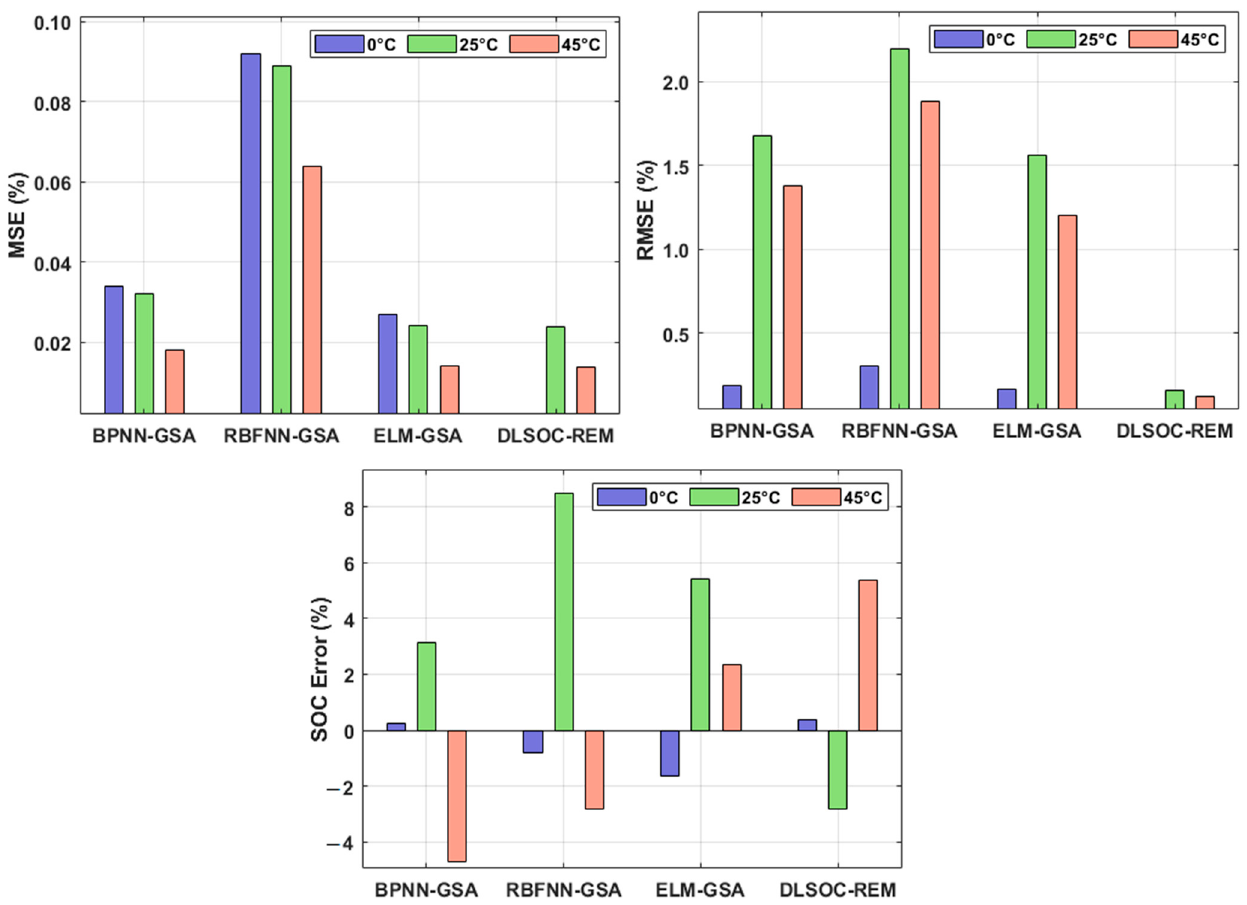
Figure 5. Comparative SOC estimation analysis of DLSOC-REM technique under US06 drive cycle.